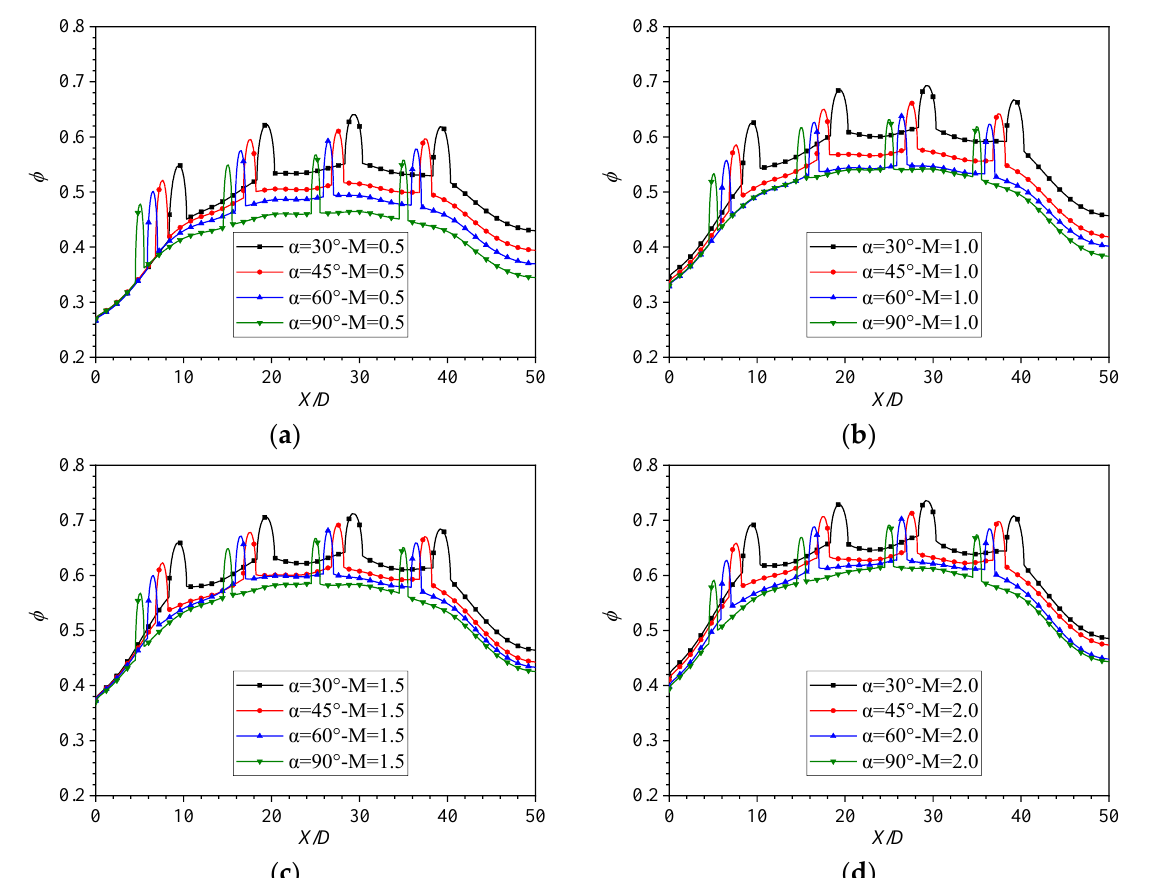
Figure 7. Laterally averaged overall cooling effectiveness for all inclinations of angled-hole cases at ( a ) M = 0.5, ( b ) M = 1.0, ( c ) M = 1.5 and ( d ) M = 2.0. ( a ) M = 0.5, ( b ) M = 1.0, ( c ) M = 1.5 and ( d ) M =